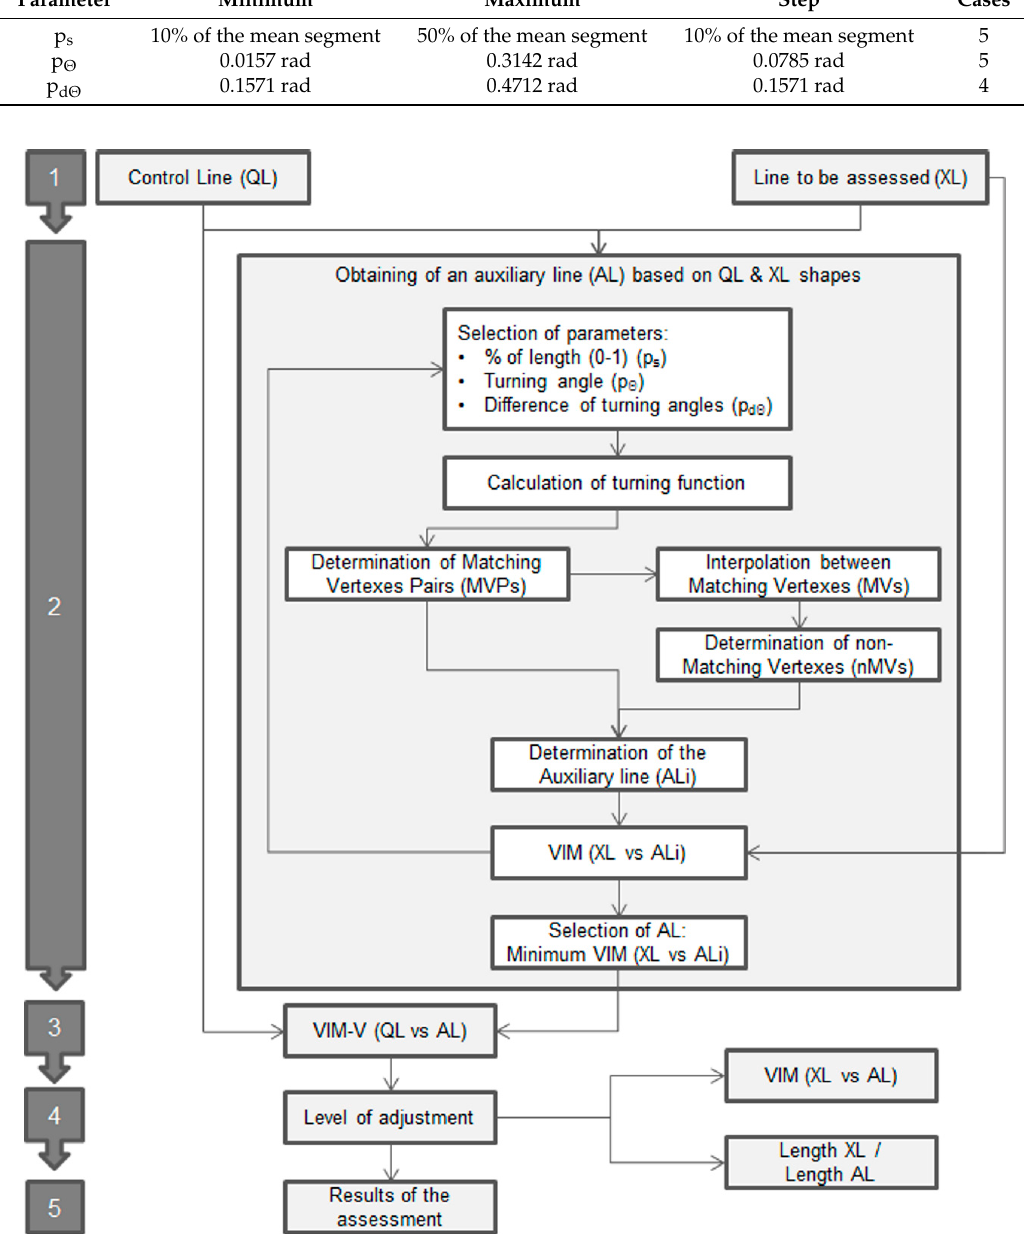
Figure 5. Method proposed in this study.